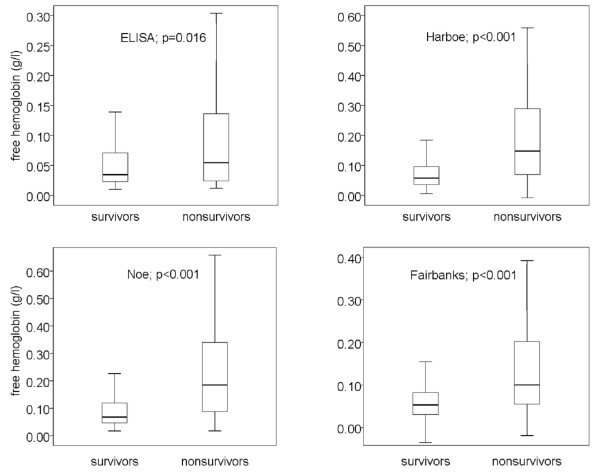
Free hemoglobin concentrations in survivors and non-survivors of severe sepsis as obtained by ELISA and three spectrophotometric methods. Data are given in boxplots (median, quartile, minimum, maximum). For statistical evaluation the Mann-Whitney test was used. Spectrophotometric methods were the methods of Harboe [13], Noe [14] and Fairbanks [15].